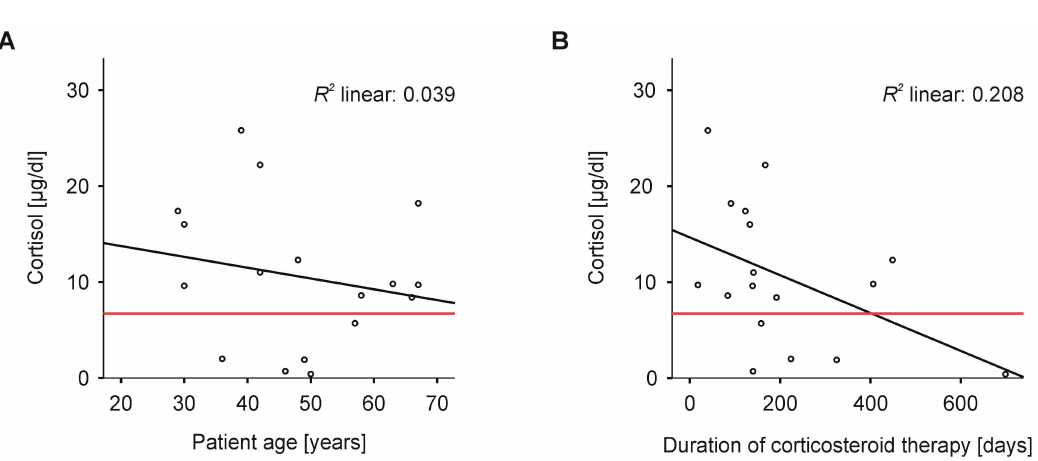
Figure 2. Correlation of cortisol levels with clinical data. Regression analysis of ( A ) patients’ serum cortisol level and their age and ( B ) patients’ serum cortisol level and duration of dexamethasone treatment did not reveal a significant correlation. The red line indicates the lower limit of the normal value of 7.25 µ g / dL (200 nmol / L) cortisol. The linear regression line is shown in